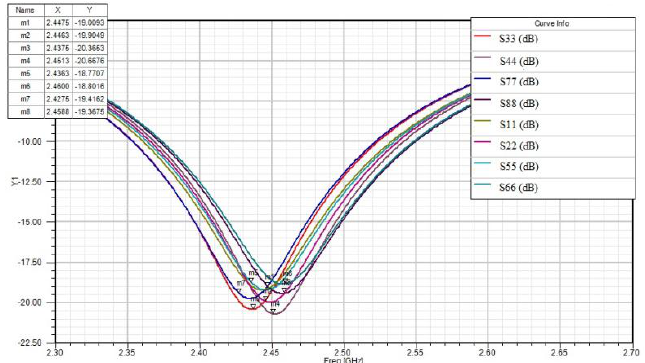
Figure 13. Simulated S –parameters (S 11 to S 88 )